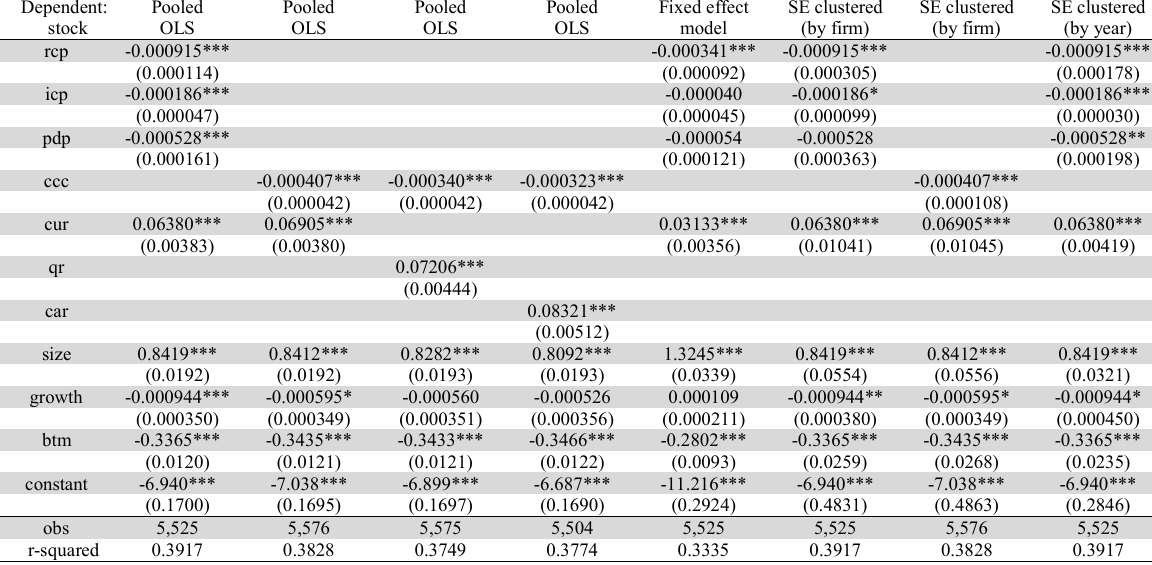
Impact of working capital management on stock performance